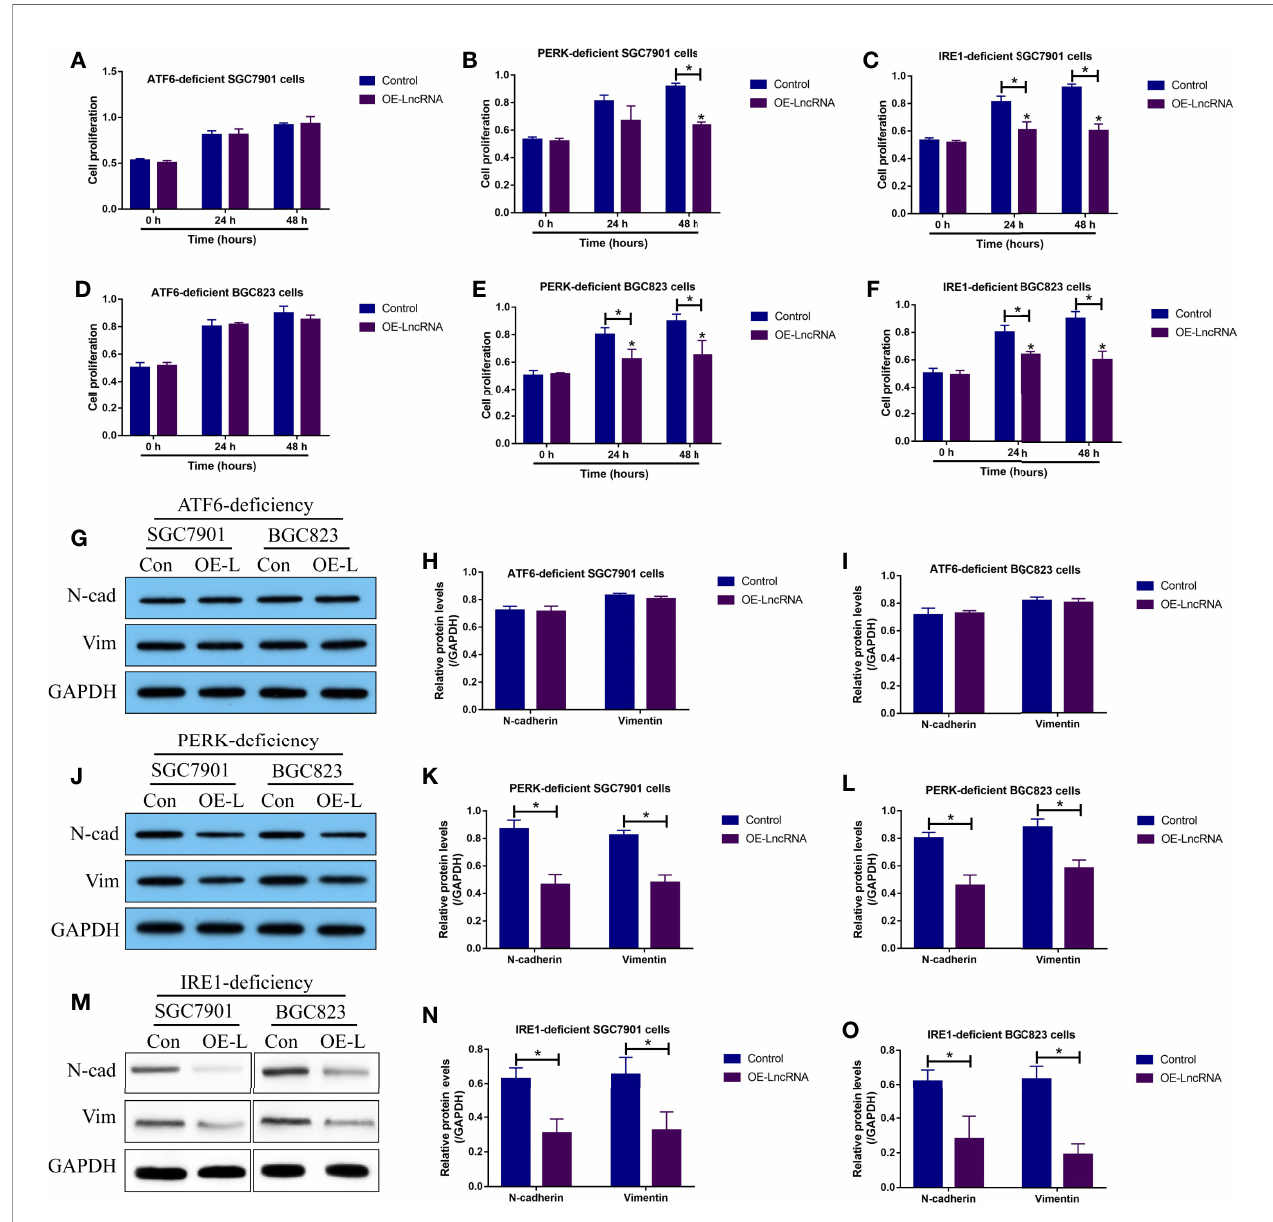
FIGURE 5 | LncRNA MIR503HG inhibited cell proliferation and EMT in GC cells by modulating ATF6-mediated UPR. The PERK-, IRE1- and ATF6-de fi cient SGC7901 and BGC823 cells were used, and (A – F) cell proliferation abilities were evaluated by using the MTT assay. (G – O) The expression status of N-cadherin